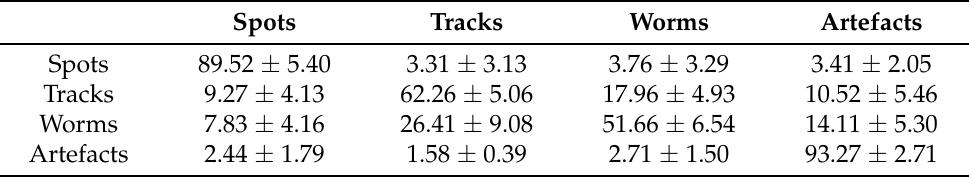
Table 4. Confusion matrix of the network with the input convolutional NASNetLarge architecture. Spots